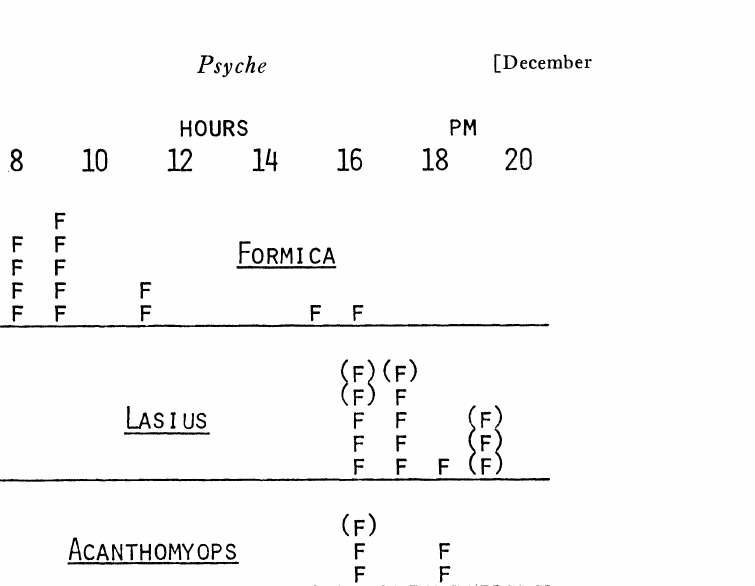
Fig. 2. Flight ho,urs. Each F represents for one species the halfway paint between the earliest and lates.t literature records of flight; () indicate the most fragmentary records. The following are represente,d: FORMICd: dakotensis (Talbot 1971), [usca (Kannowski 1959a; Talbot 1965),